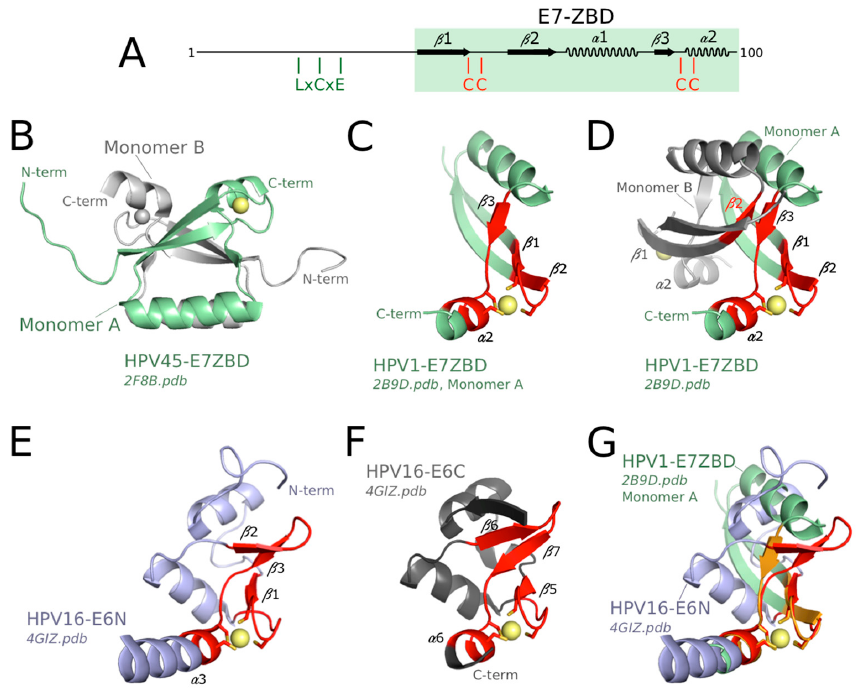
Figure 3. Structure of mammalian papillomavirus (PV) E7 ZBD and comparison to mammalian PV E6N and E6C. ( A ) Schematics of mammalian HPV E7 sequence. Mammalian PV E7 proteins contain an intrinsically unfolded N-terminus bearing a conserved LxCxE sequence (as indicated on the sheme) among other putative interaction motifs, followed by a folded zinc-binding domain (E7-ZBD) shaded in green, with four conserved cysteine (C) residues as indicated; ( B ) Solution structure of HPV45 E7 ZBD homodimer [76]. A comparable structure was also obtained by crystallography for the E7 ZBD of HPV1 E7 [78]; ( C ) Elements of the treble clef motif of E7 ZBD (in red) in context of the E7 ZBD monomer; ( D ) Elements of the treble clef motif of E7 ZBD (in red) in context of the E7 ZBD dimer; ( E ) Elements of the treble clef motif of E6N (in red); ( F ) Elements of the treble clef motif of E6C (in red); ( G ) Superimposition of HPV1 E7-ZBD and HPV16 E6N, enlighting common features of their treble clef motifs, indicated in orange and red color, respectively. Spheres are Zinc (II) atoms.